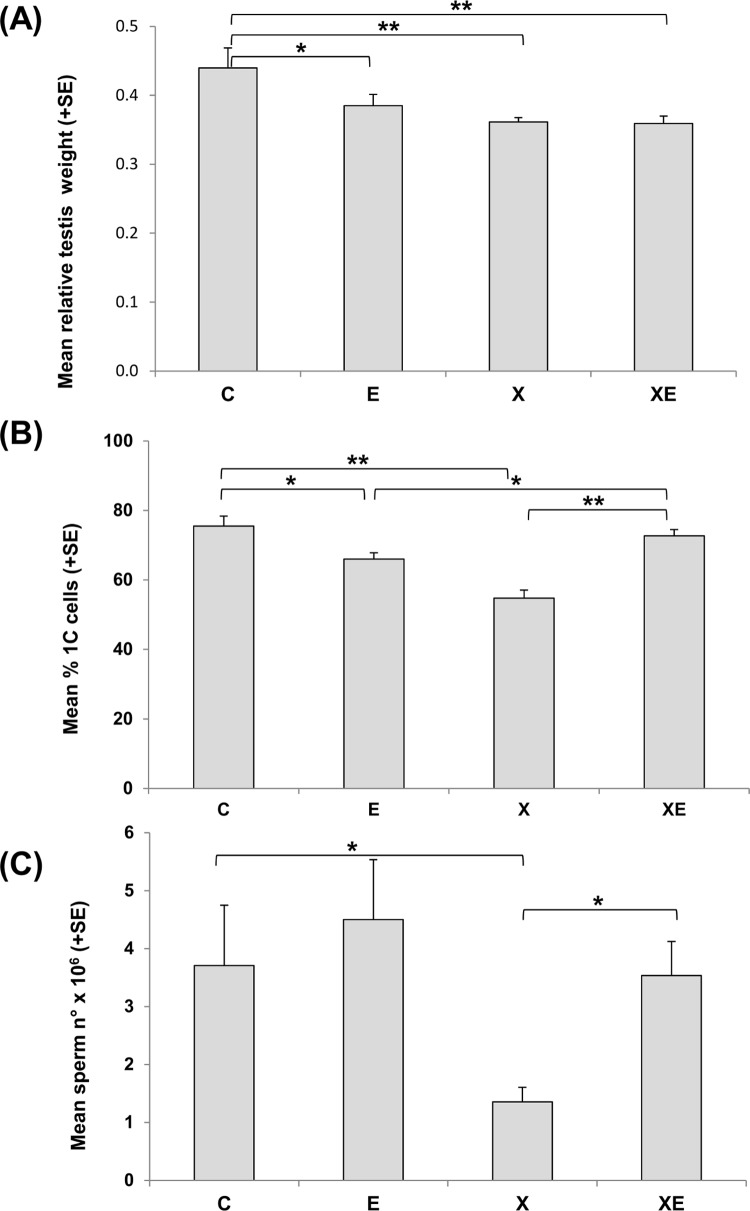
(A) Relative testicular weights (testis weight/body weight * 100); (B) percentages of 1C post meiotic cells as evaluated by DNA content flow cytometric analysis of whole testis cells; (C) sperm number in cauda epididymis.Columns represent the mean values of 7 controls (C), 11 ELF-MF exposed (E), 14 X-rays exposed (X), or 11 animals exposed to combined treatments (XE). Asterisks mark statistically different values between groups, *: p<0.05; **: p<0.005.